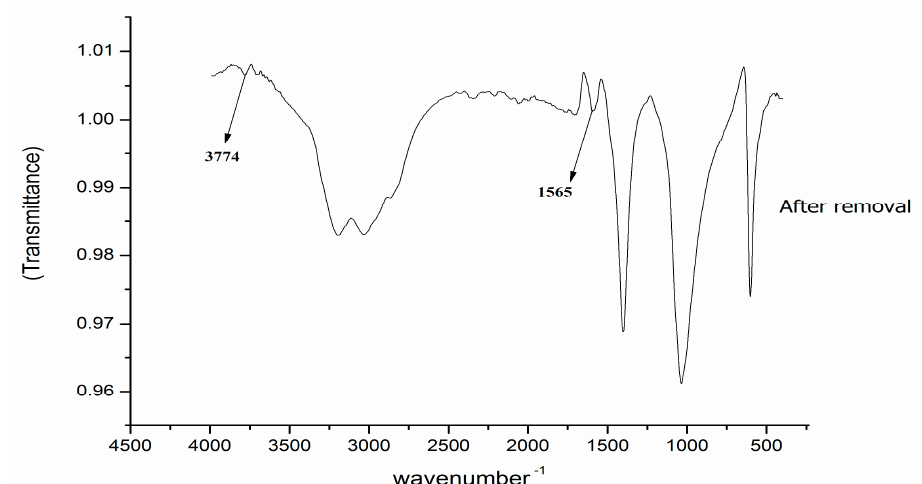
Figure 2. FTIR spectra of the water-soluble protein powder before and after the removal of multiclass antibiotics.